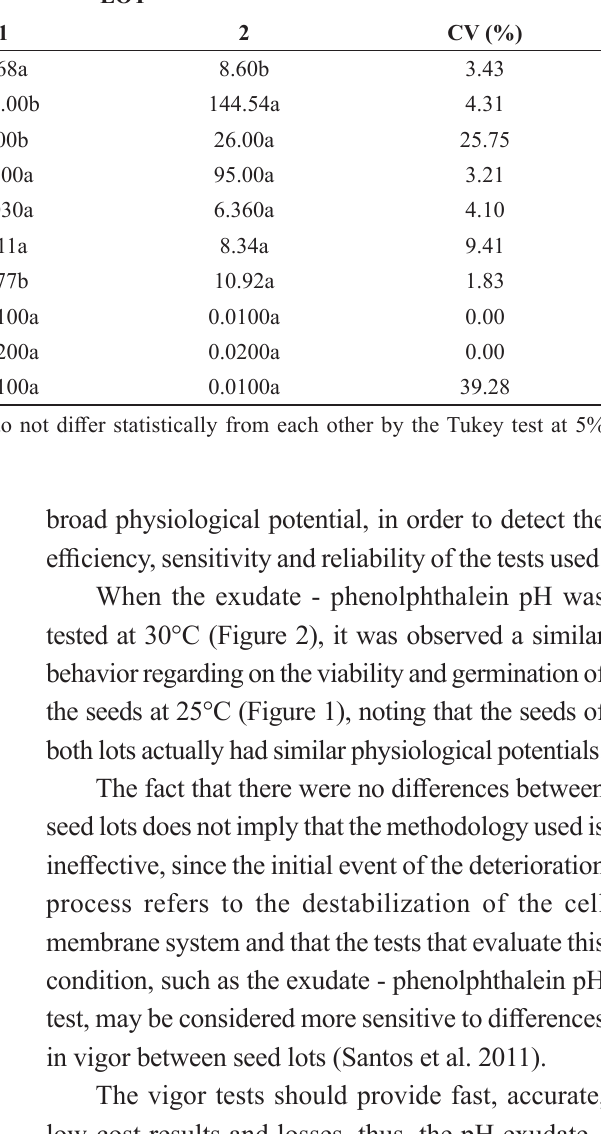
QUICK TeST FOr eVALUATION THe SeeDS OF Libidibia ferrea